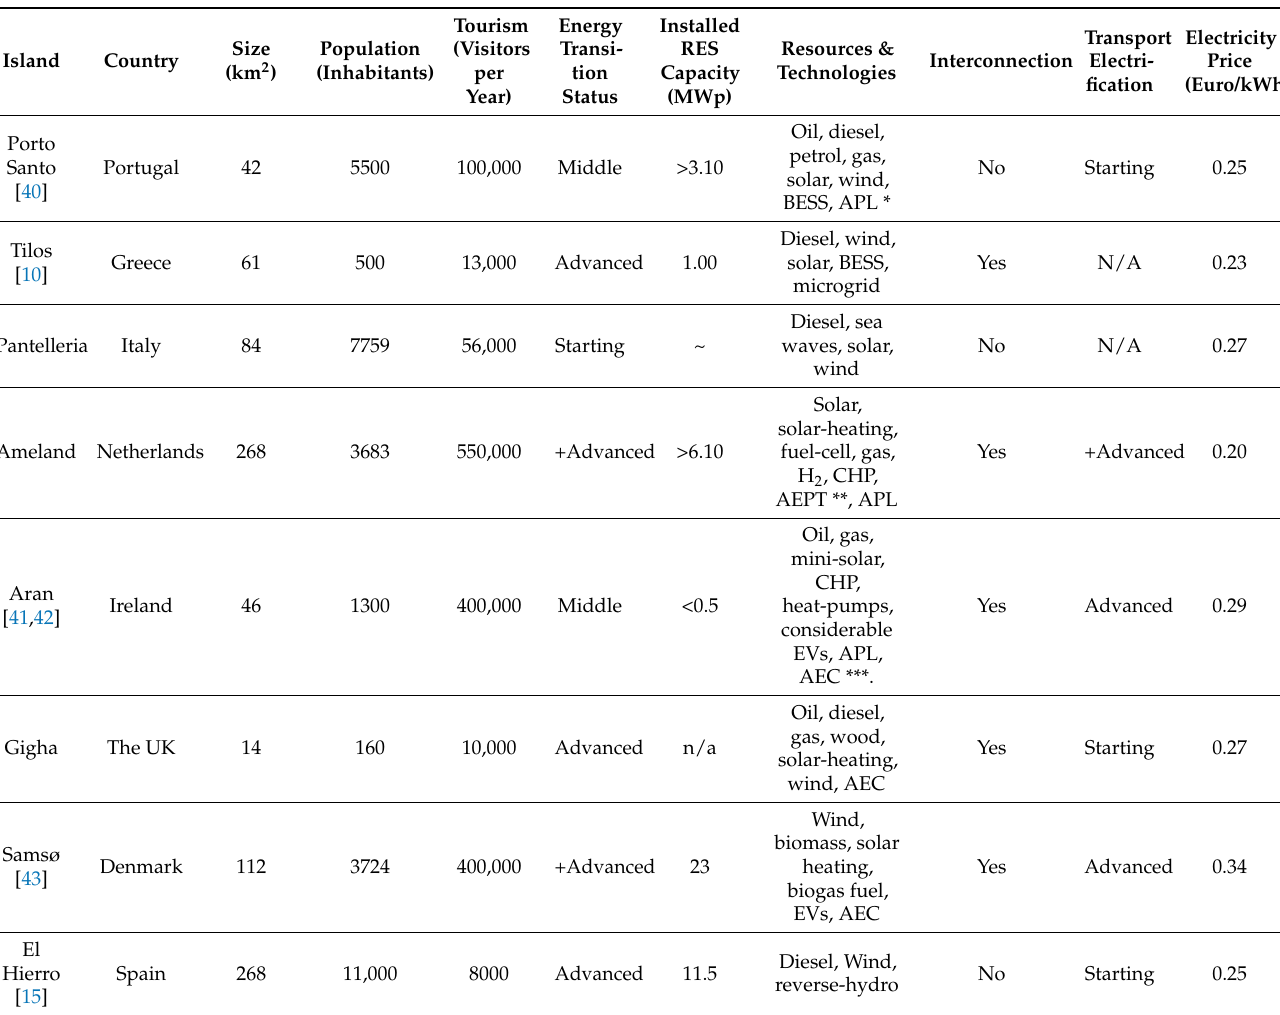
Table 2. Key characteristics of Porto Santo and other selected